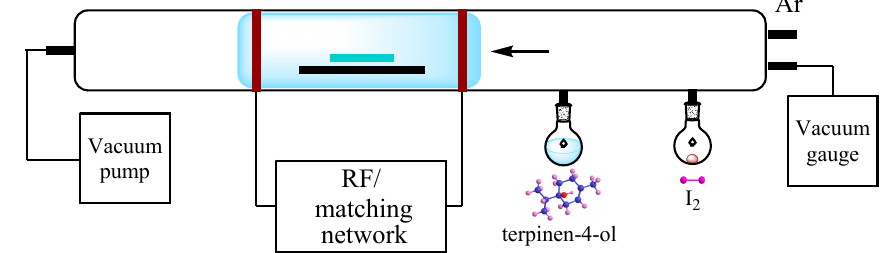
Figure 7. Schematic of the plasma polymerization system. Inter-electrode distance is 10 cm. Deposition takes place within the plasma glow, with terpinen-4-ol and iodine vapours released into the glass chamber concurrently, in the absence of heating or carrier gas.